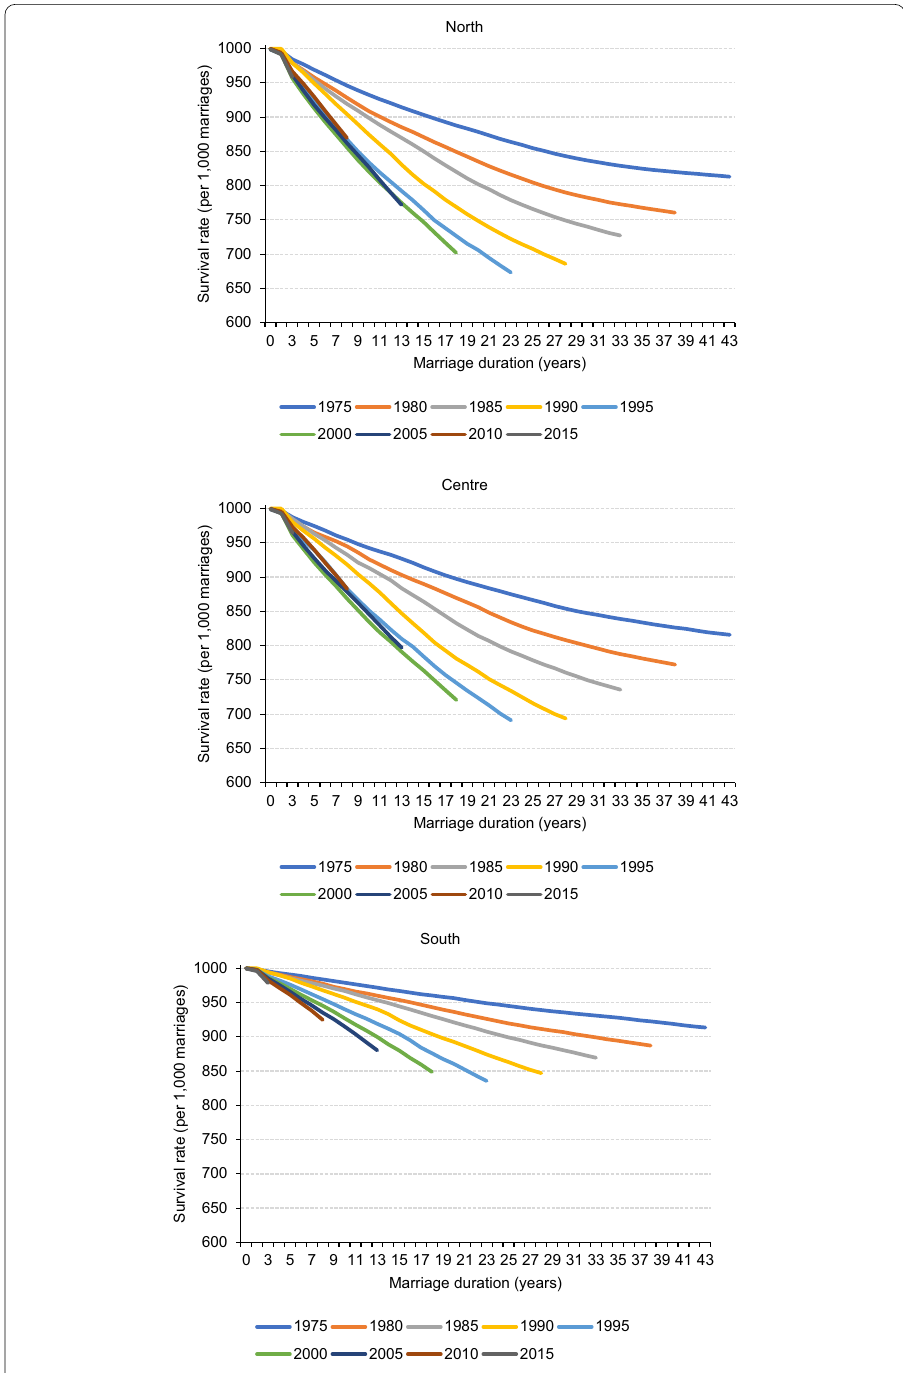
Fig. 5 First marriages surviving at separation by duration of marriage, marriage cohort, and geographical area (survival rates per 1000 marriages), Italy. Source Author’s elaboration of Istat data on marriages and